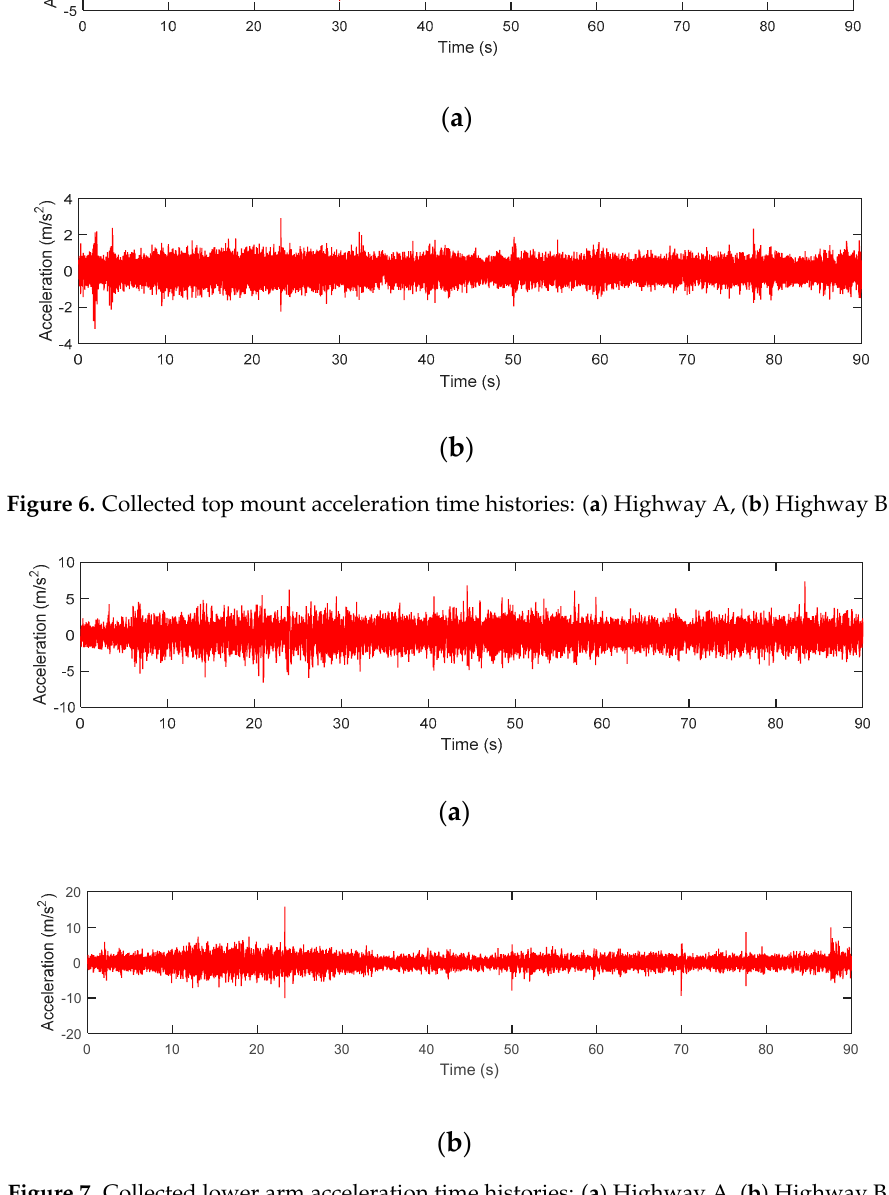
Figure 7. Collected lower arm acceleration time histories: ( a ) Highway A, ( b ) Highway B.